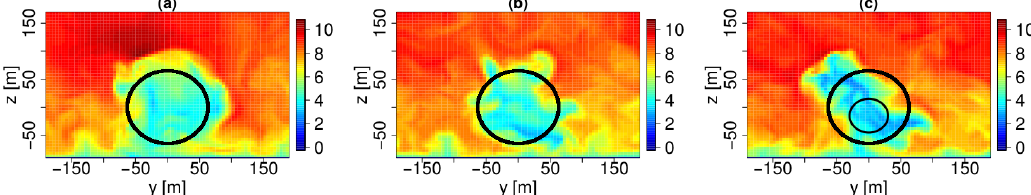
Figure 3. Snapshots of the LES showing the the stream-wise velocity u ( ms − 1 ) in a yz -plane 3.5 D away from the turbine. ( a ) t = 990 s; ( b ) t = 1185 s; ( c ) t = 1230 s. The large black circle marks the rotor area of a turbine in the wake flow, which is modeled later using aeroelastic simulations. The small black circle marks the central region of the wake, which is used to build a spectral surrogate in Section